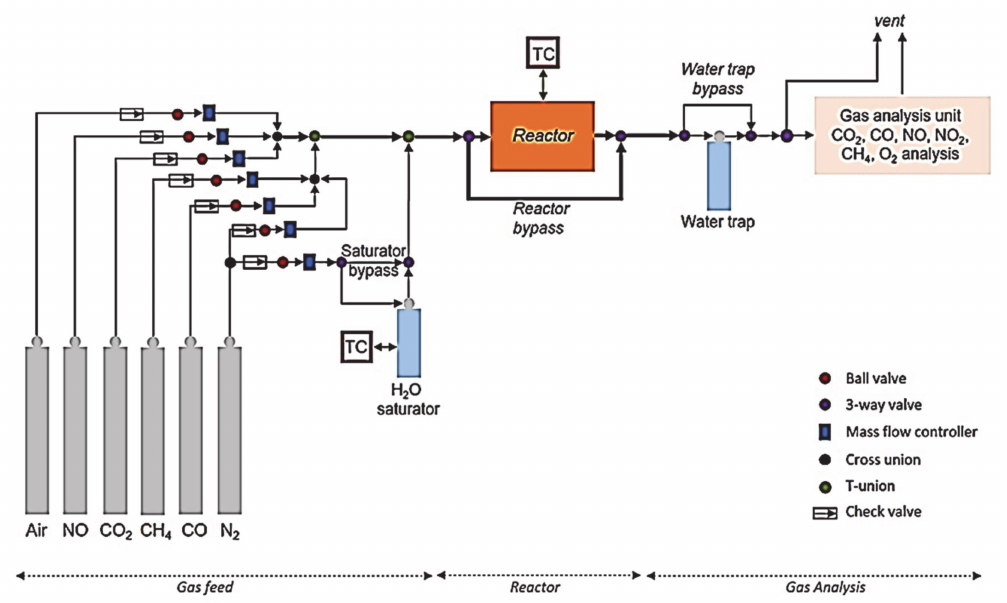
Figure 6. Schematic representation of the experimental setup used for the catalytic activity test of catalysts.